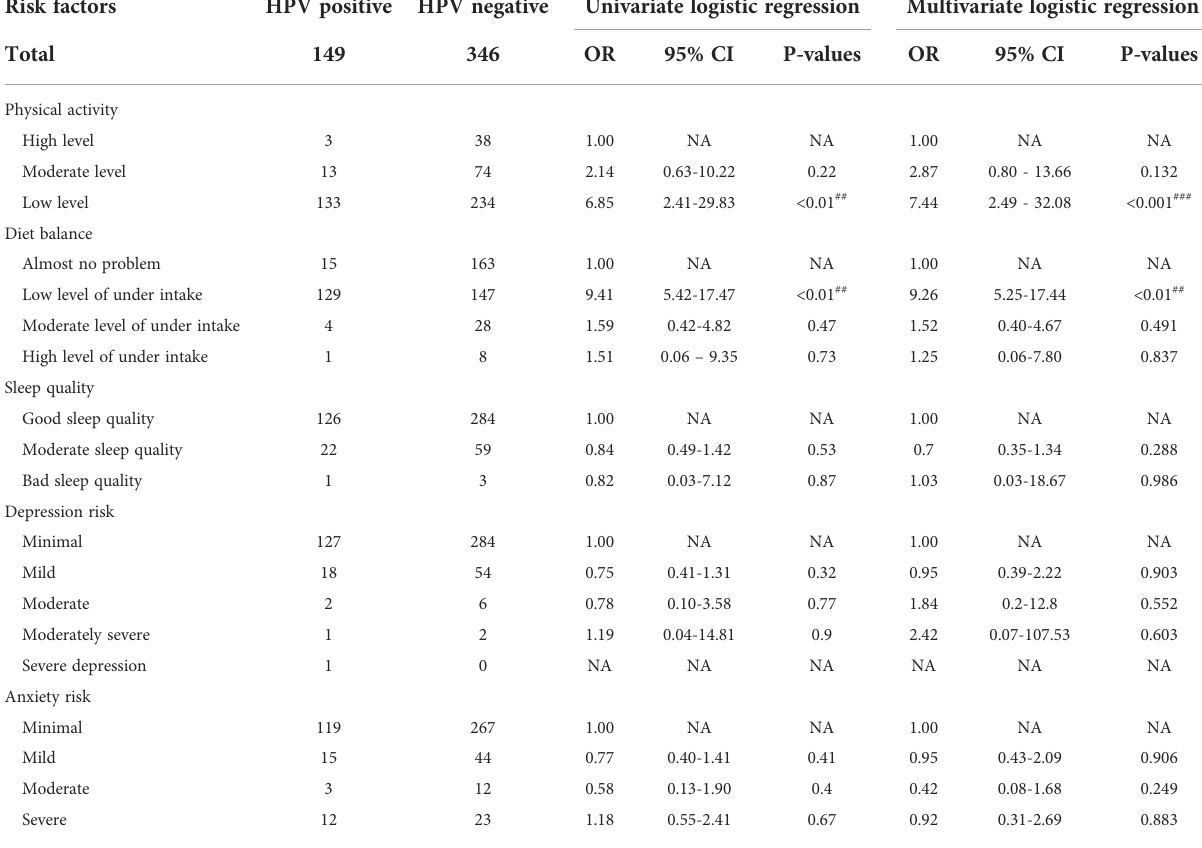
TABLE 3 Risk of HPV infection in different levels of lifestyle factors from univariate and multivariate logistic